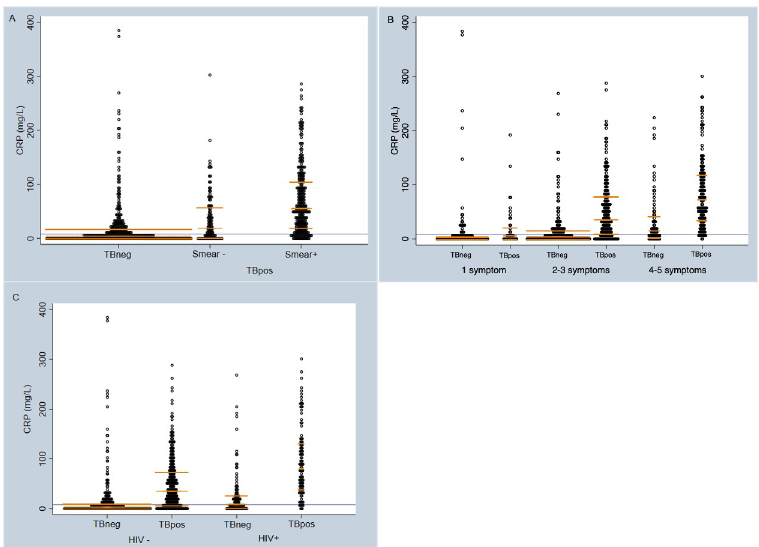
Fig 1. The distribution of CRP amongst all study participants (n = 765). A) by TB and smear status; B) by TB status and number of symptoms at presentation; C) by TB and HIV status. Lavender line demarcates a CRP threshold of 8mg/L–subjects below this line would not go forward for further testing in a triage-based algorithm. Gold lines demarcate median and inter-quartile range. TBneg = tuberculosis negative by MRS. TBpos = tuberculosis positive by MRS. HIV = human immunodeficiency virus. CRP = C-reactive protein.